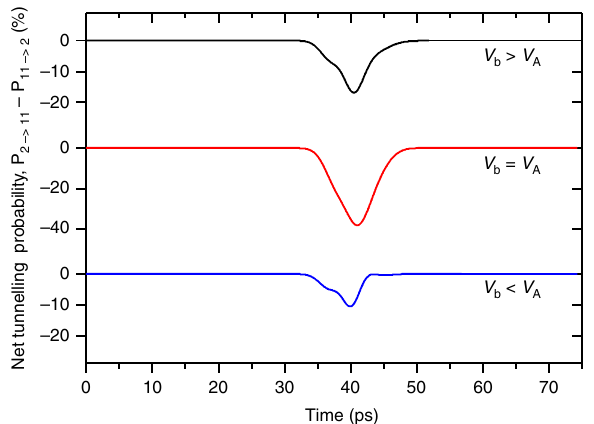
Fig. 5 Net tunnelling probabilities for the perturbed QCL device using a time-dependent model. Time-dependent net tunnelling probabilities between the injection level (|2 〉 ) and the upper laser level (|11' 〉 ) due to transit of the acoustic wave, calculated using a time-dependent perturbation model for QCL biases below subband alignment ( V b < V A , V = 3.53 kV cm − 1 ), at alignment ( V = V V = 3.63 kV cm − 1 ) and above b b A , b alignment ( V b > V A , V b = 3.85 kV cm − 1 ). The timescale of the simulation is set so that the pulse can propagate over two adjacent periods. Source data are provided as a Source Data fi